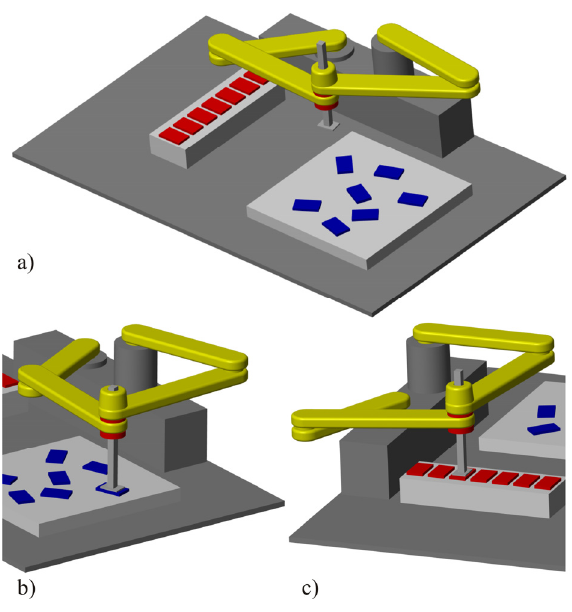
Figure 9. An example of the system verification The start position and orientation of the objects